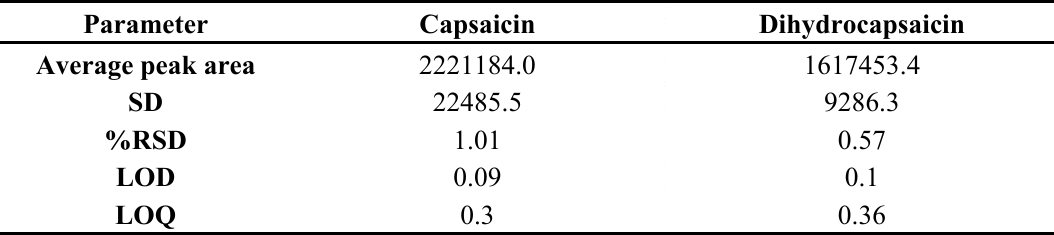
Table 1. Relative standard deviation, limits of detection (LOD) and quantitation (LOQ) for capsaicin and dihydrocapsaicin.